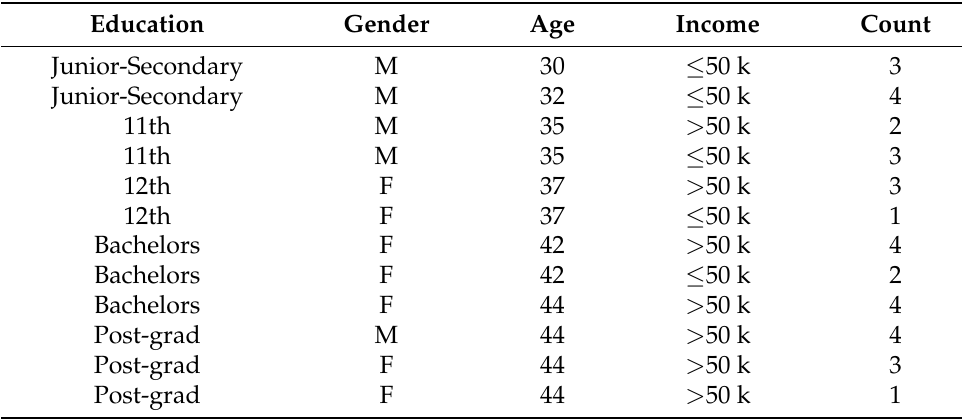
Table 3. The result of the first generalization applied to the original dataset.